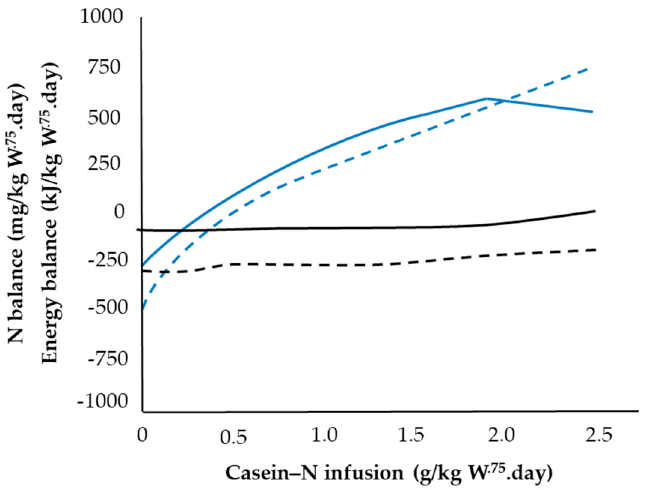
Figure 6. N (blue lines) and energy (black lines) balances of lambs given incremental casein with (solid lines) or without (dashed lines) 250 kJ/kg W .75 .day from a volatile fatty acid mixture. Adapted with permission from [62].